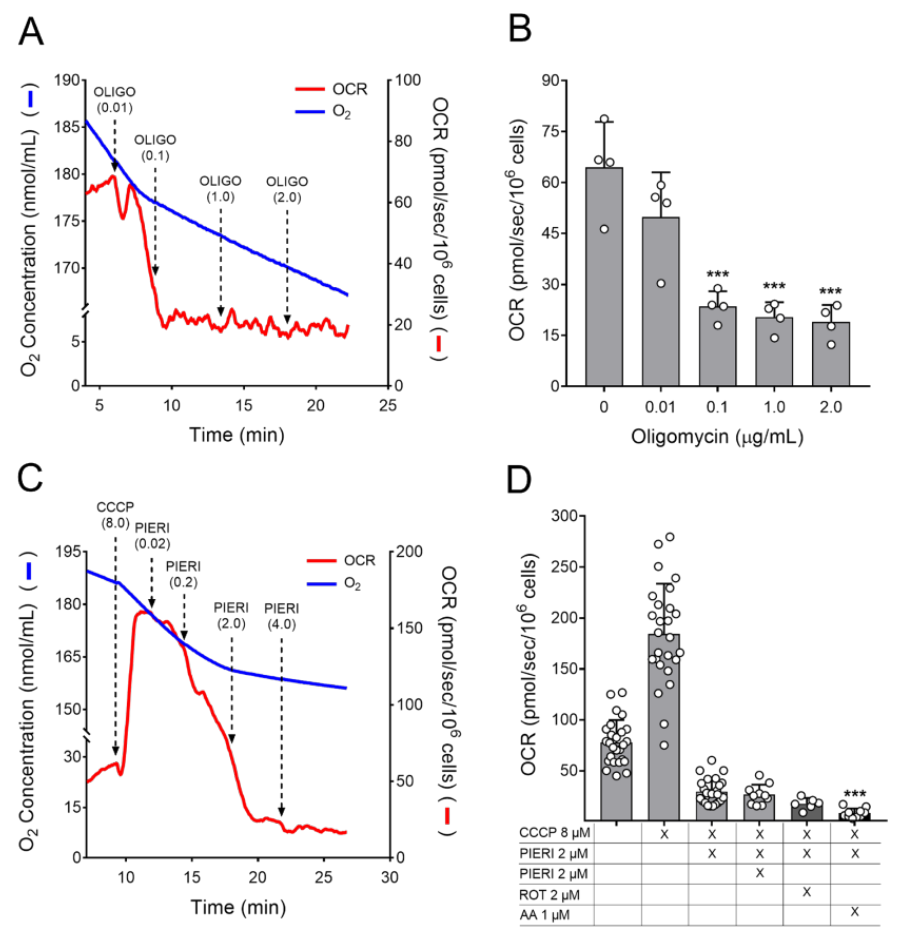
Figure 2. Effect of oligomycin and piericidin A on the oxygen consumption rate (OCR) of astrocytes in suspension. Astrocytes (7.5 × 10 5 /mL) were resuspended in Medium 3 containing 20 mM HEPES- Na + , and OCR was monitored in a high-resolution oxygraph. ( A ) Representative trace of OCR in suspended astrocytes. As indicated by the arrows, oligomycin (OLIGO) additions were made until reaching the final concentration of 2.0 µ g/mL. The oligomycin concentrations in µ g/mL achieved after each addition are shown in parentheses. ( B ) OCR values obtained after sequential additions of oligomycin. *** Statistically different from basal in the absence of oligomycin, by one-way ANOVA, post-hoc Bonferroni, p < 0.001. ( C ) Representative trace of OCR in suspended astrocytes. As indicated by the arrows, additions of piericidin A were made until reaching a final concentration of 4.0 µ M. The piericidin A concentrations in µ M achieved after each addition are shown in parentheses. ( D ) OCR values obtained under basal condition and after additions of 8 µ M CCCP, piericidin A (PIERI; 2 and 4 µ M) plus rotenone (ROT; 2 µ M) or antimycin (AA; 1 µ M) as indicated. Statistically different from OCR in the presence of 8 µ M CCCP plus 2 µ M piericidin A, by Kruskal-Wallis followed by Dunn’s multiple comparisons test, *** p < 0.001.